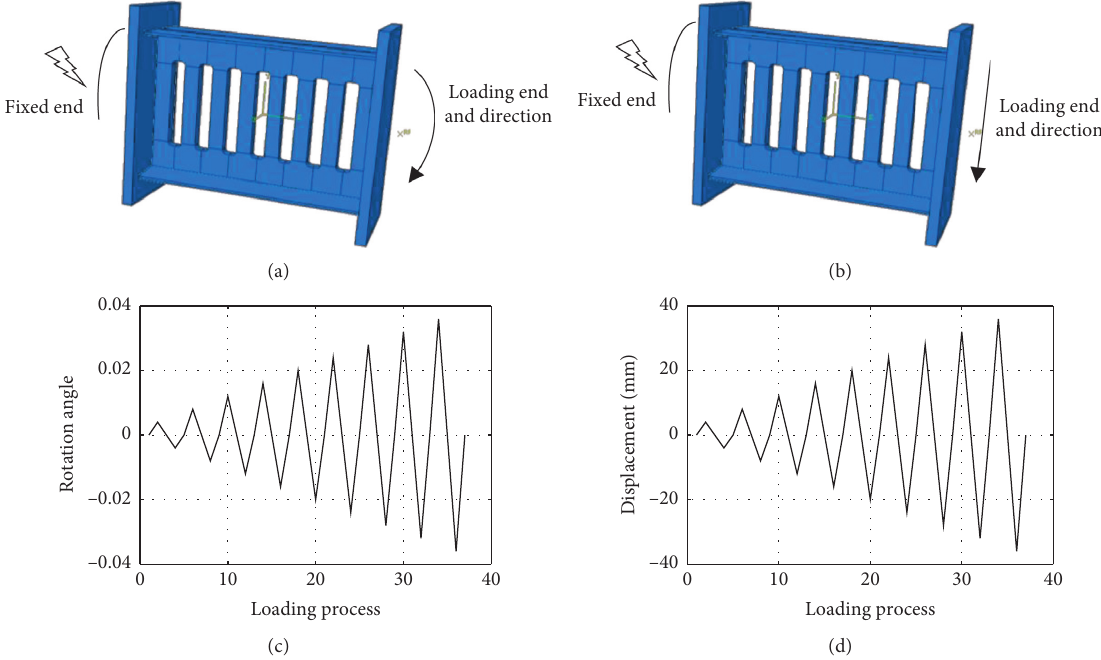
Figure 10: Analysis model and loading system. (a) Analysis model of loading in bending direction. (b) Analysis model of loading in shear direction. (c) Loading system in bending direction. (d) Loading system in shear direction.